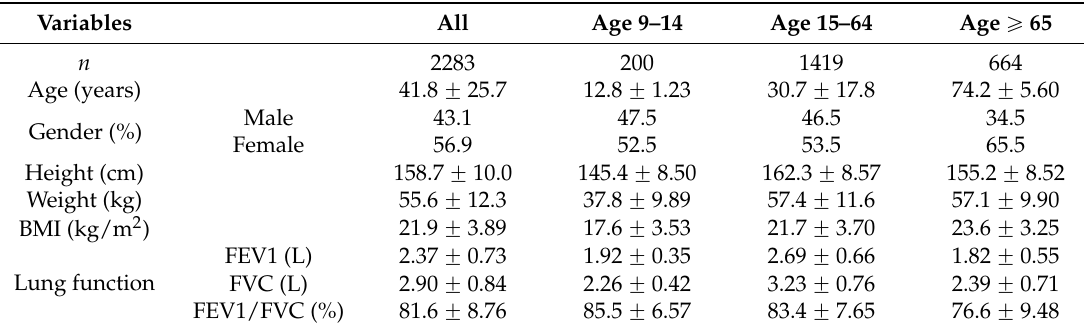
Table 4. Demographic characteristics of the study